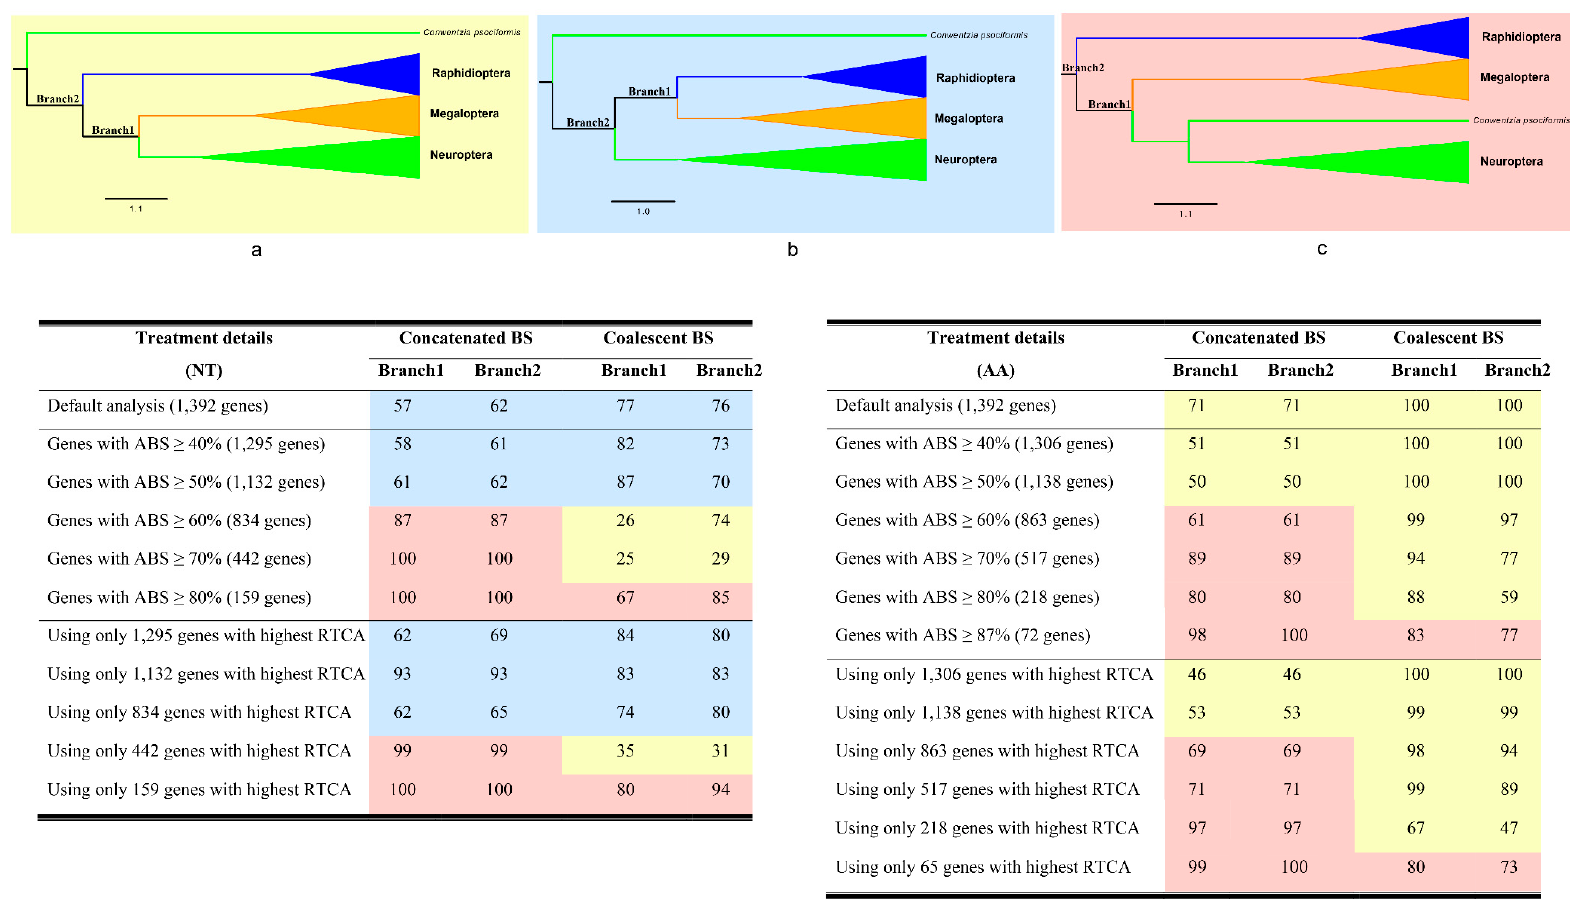
Figure 4. Topology changes as using genes with strong phylogenetic signals under homogeneous model. Different background color indicates the different topology, respectively. Yellow: Topology ( a ); blue: Topology ( b ); pink: Topology ( c ). NT: Nucleotide. AA: Amino acid. ABS: average bootstrap support. RTCA: Relative tree certainty including all conflicting bipartitions.